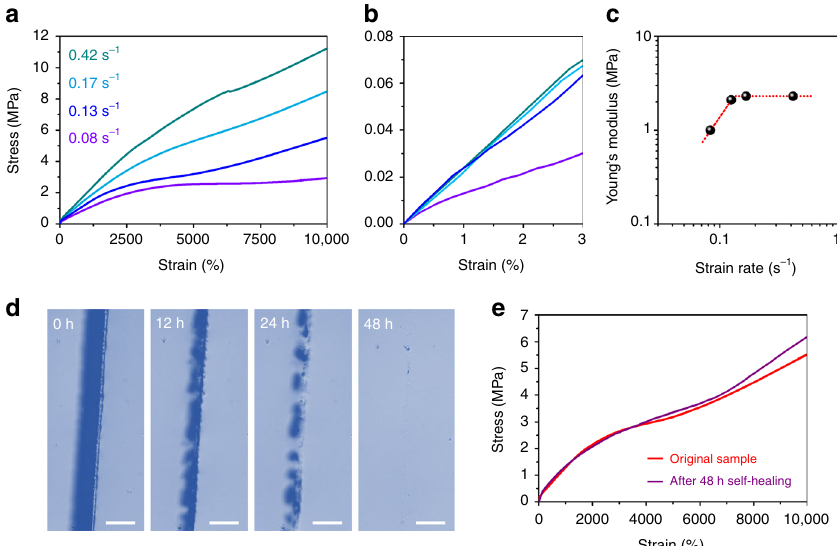
Fig. 2 Mechanical properties. a True tensile curves of the intrinsically stretchable conductor at different strain rates. b True tensile curves of the conductor at small strain. c Young ’ s modulus of the intrinsically stretchable conductor at different strain rates. d Optical micrographs record the autonomously self- healing process of the conductor (scale bar: 100 μ m). e True tensile stress – strain curves of the original and self-healing conductor